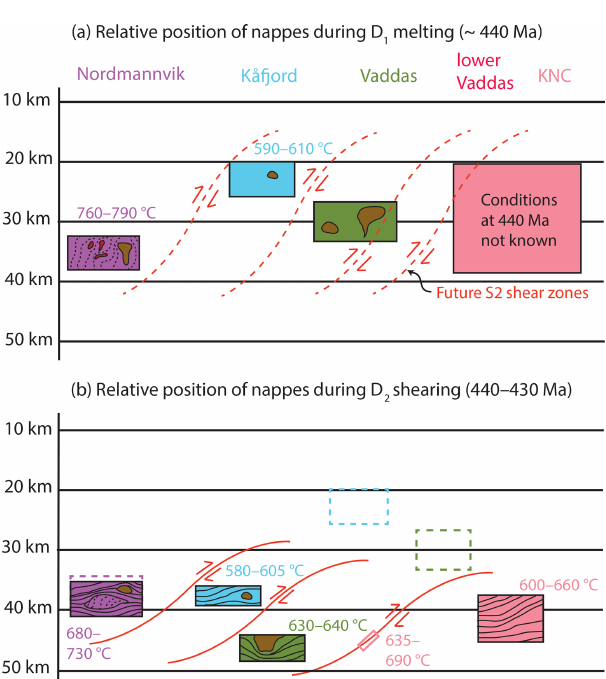
Figure 14. Relative positions and temperatures of the RNC nappes and KNC during (a) early Silurian heating (D 1 melting and gabbro intrusion) and (b) D 2 shearing, focussing on the sections through Arnøya and Uløya (lower Vaddas not present). D 1 conditions are shown in dashed, coloured boxes for comparison. In both (a) and (b) S 1 is shown as a dashed black line, and S 2 as a solid black